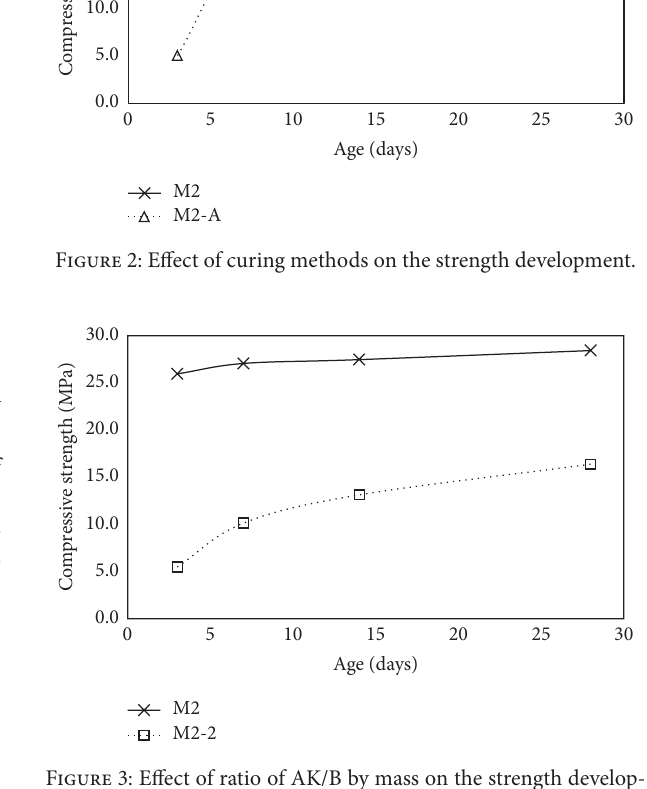
Figure 3: Effect of ratio of AK/B by mass on the strength develop-